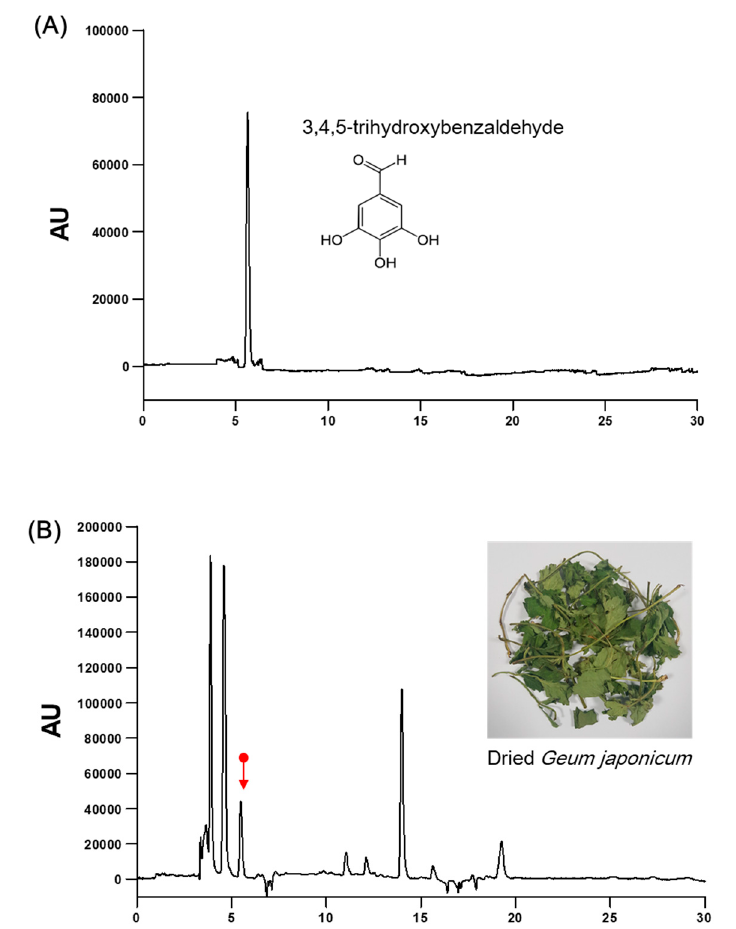
Figure 1. High-performance liquid chromatography (HPLC) chromatogram for standardization of G. japonicum extract. ( A ) HPLC chromatograms for 3, 4, 5-trihydroxybenzaldehyde and ( B ) G. japonicum extract. X-axis, retention time (min); Y-axis, absorbance unit (AU).